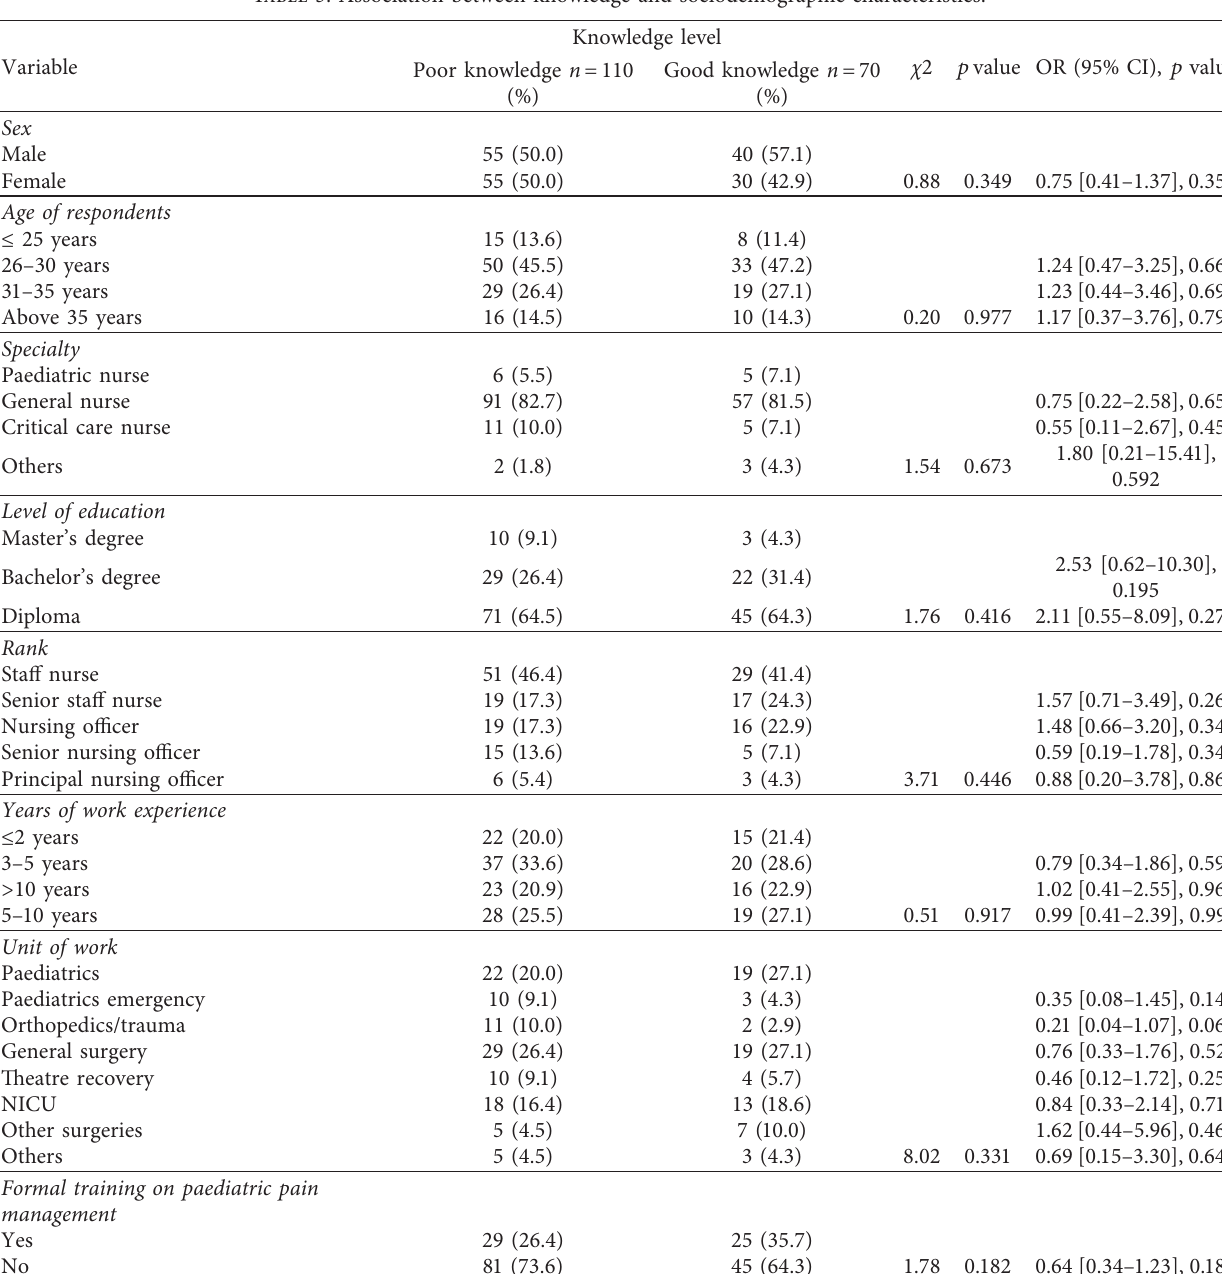
Table 3: Association between knowledge and sociodemographic